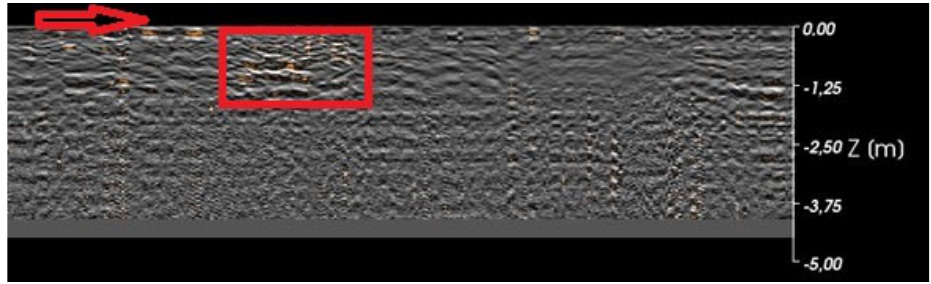
Figure 9. Alterations detected on the radargram.